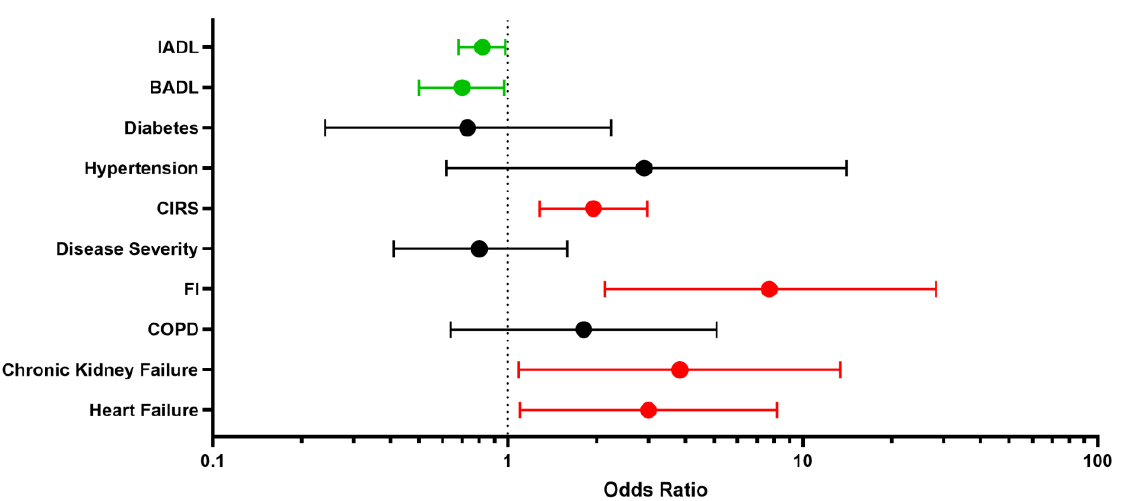
Figure 1. Determinants of re-hospitalization: risk factors (red) and protective factors (green). Forest plot. BADL indicates B asic A ctivities of D aily L iving; IADL , I nstrumental A ctivities of D aily L iving; CIRS , C umulative I llness R ating S cale; FI , F railty I ndex; COPD , C hronic O bstructive P ulmonary D isease.